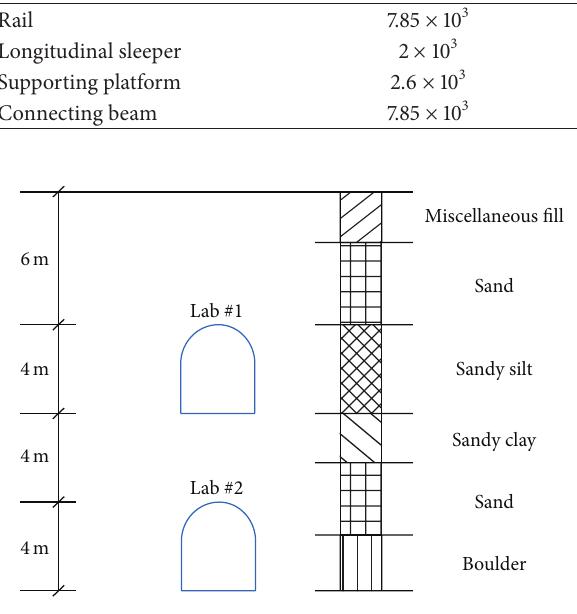
Figure 1: Section plan of the laboratory. Figure 2: Ladder track located in Lab